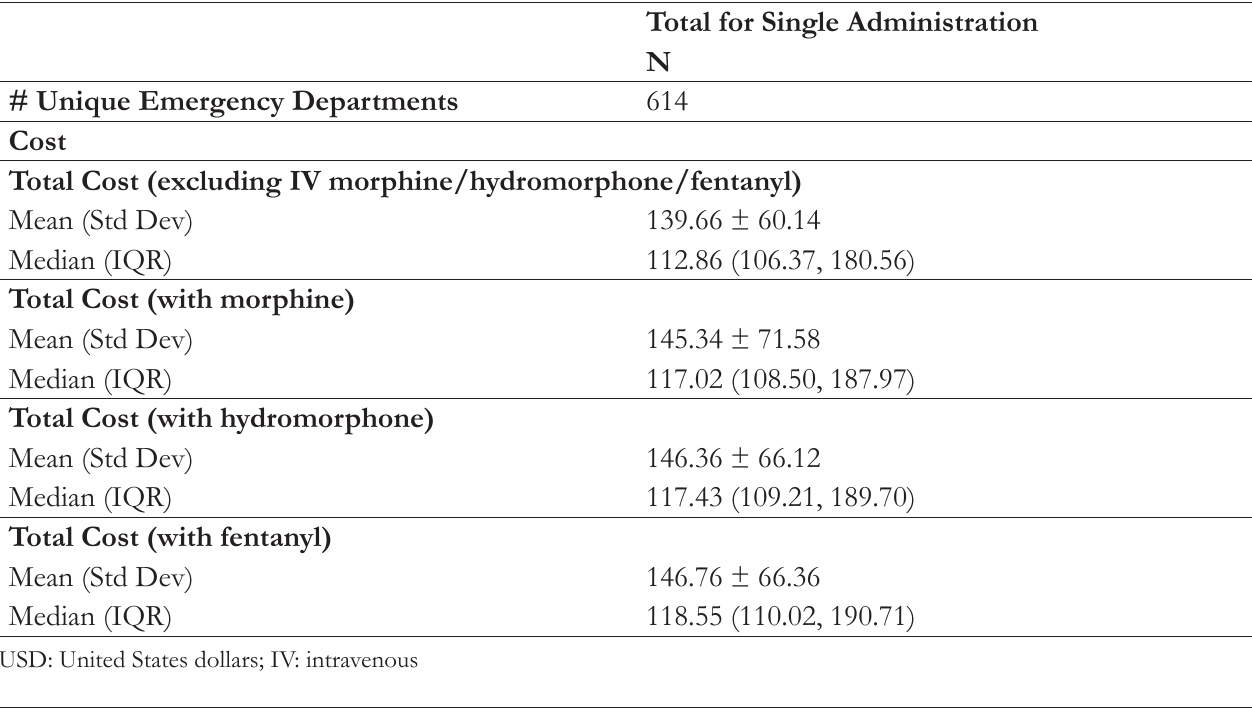
Table 5. Total Costs (2016 USD)